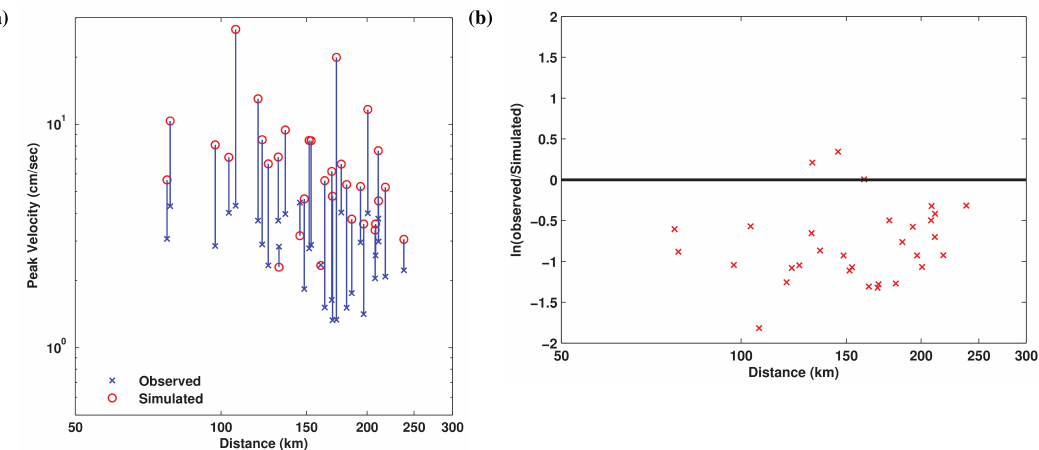
Figure 9. (a) Comparisons of peak ground velocity (PGV) of the simulated and the recorded broadband ground motions as a function of station distance to the hypocenter of the 1999 Hector Mine earthquake. (b) Natural log of the residual of simulated and recorded values.